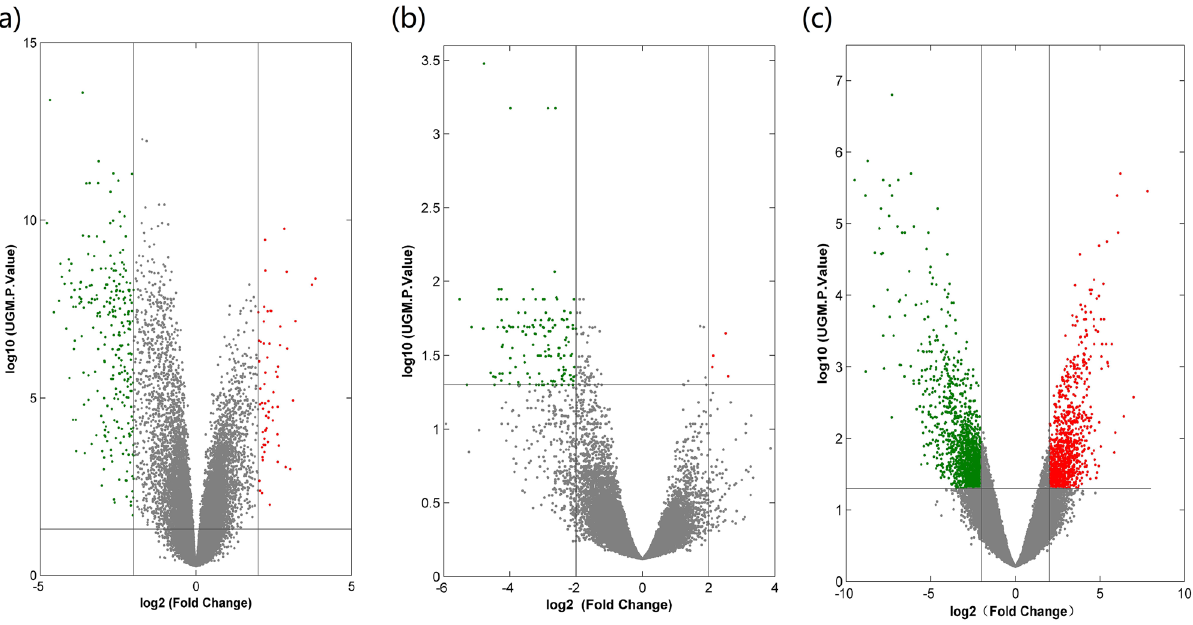
Figure 2. The volcano plots of DEGs in GSE12452 ( a ), GSE64634 ( b ) and GSE34573 ( c ) microarrays. The genes marked in red are upregulated genes, green marked are downregulated genes, and the gray represents non- differential expression genes at the cutoff P value < 0.05 and |log FC|> 2.0. The picture was drawn using online tool Venny (http:// bioin fogp. cnb. csic. es/ tools/ venny/ index. html,